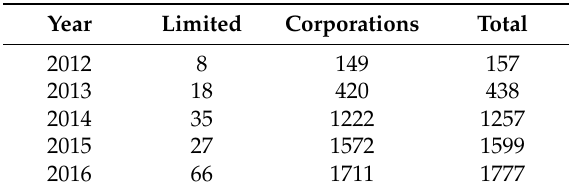
Table 1. The number of new firms with Syrian partners.